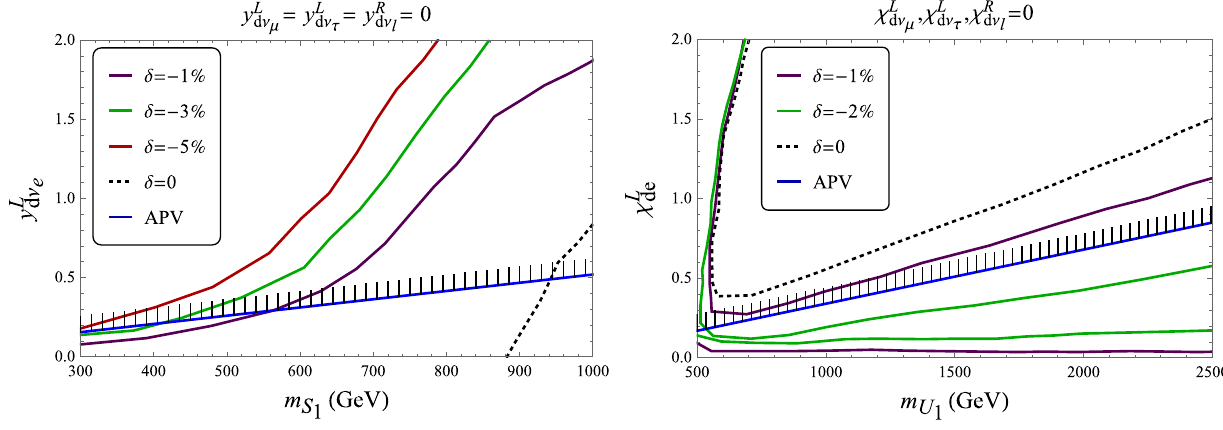
Fig. 6 The contour lines of constant δ in the m S showing the percent change of χ 2 compared to the SM case. The region to the right of the dotted curve in case of S 1 and above the dotted curve